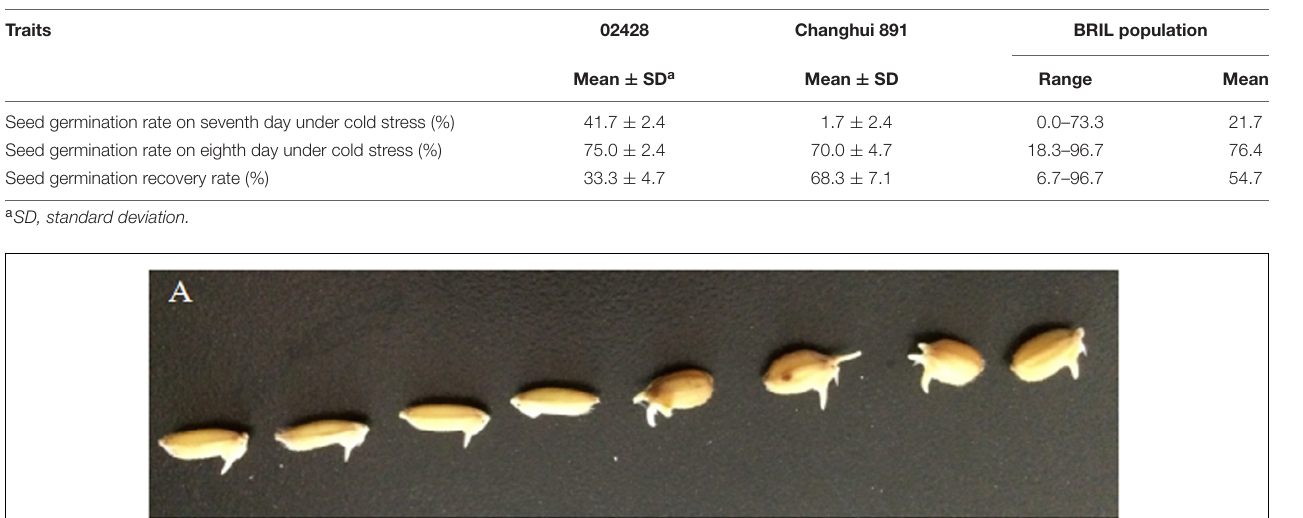
TABLE 1 | Performance of parents and BRIL population for seed germination under cold stress.